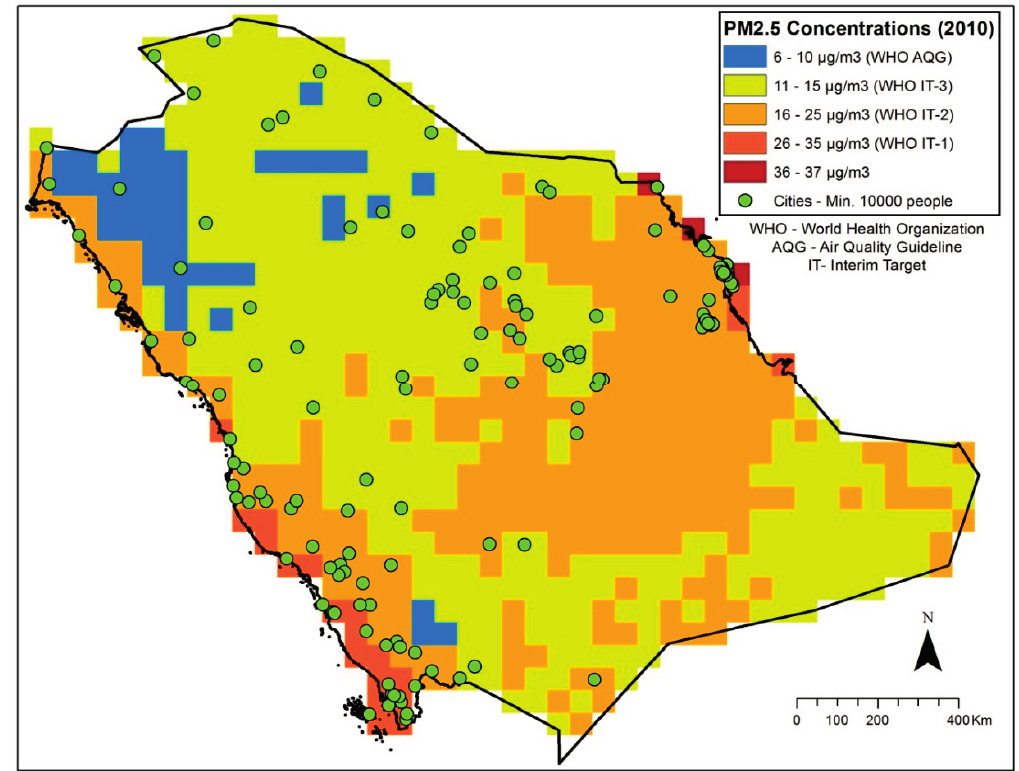
Figure 4. PM 2.5 concentrations (un-weighted) in